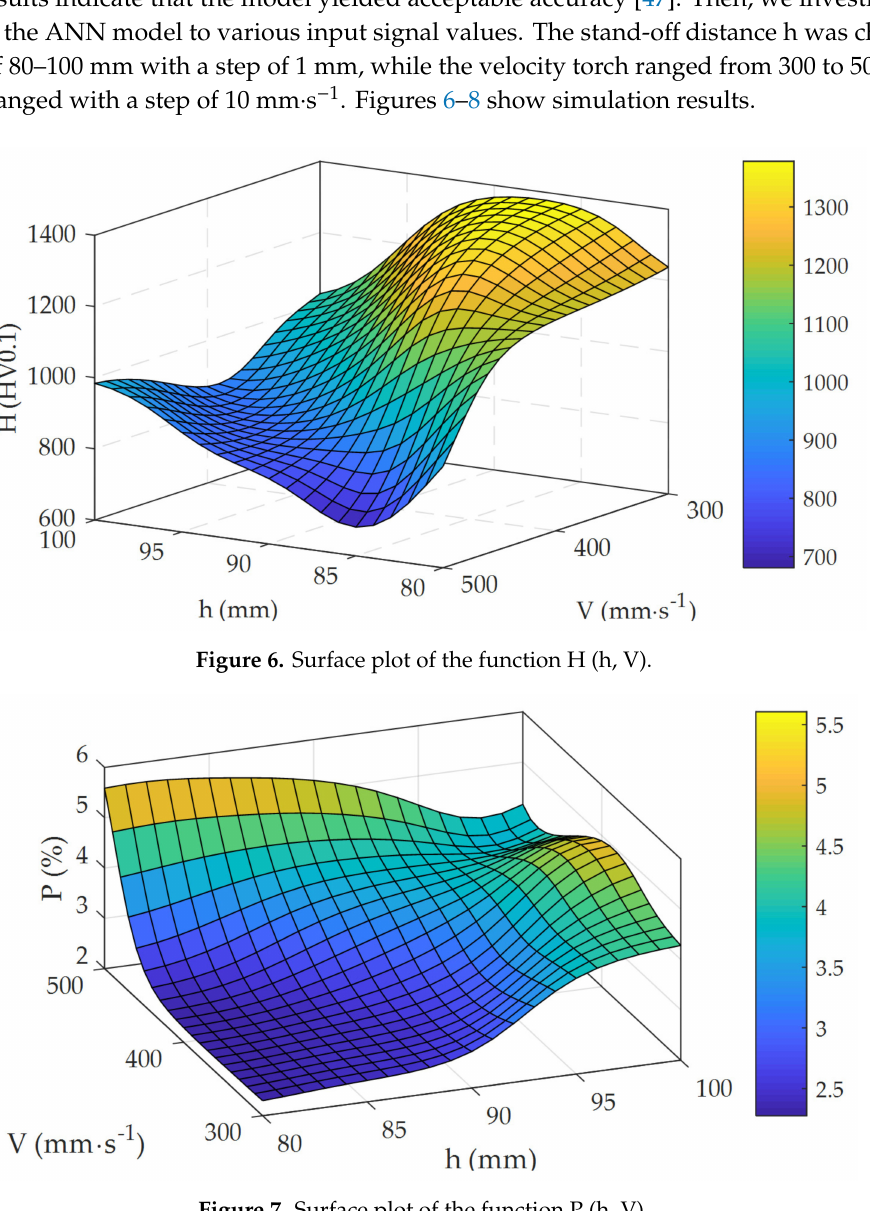
Figure 7. Surface plot of the function P (h,